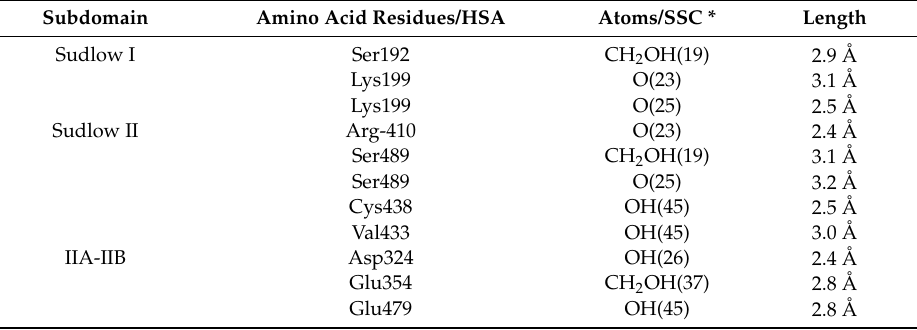
Figure 8. Optimal binding conformation of the SSC-HSA complex ( A ). Amino acid residues of Sudlow I ( B ); or Sudlow II ( C ) or IIA-IIB binding site ( D ) surrounding SSC within 4 Å. The cyan structure stands for HSA. The pink, green, or brown is for SSC, and a dotted line for hydrogen bonding. Table 6. Atoms and amino acid residues involved in the hydrogen bonds between SSC and HSA.